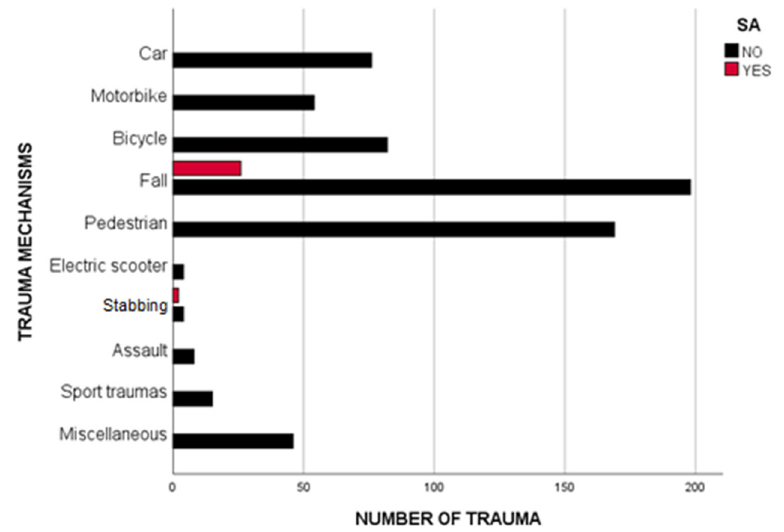
Figure 3. Trauma mechanisms in SAs in the overall period. Fall-related injuries were the predominant trauma mechanism of SAs in our series. The only other mechanism highlighted was self-stabbing. Median patients’ vital signs at first pre-hospital detection and on arrival at the ED are depicted in Table 2. Table 2. Clinical presentation: pre-hospital and ED vital signs. 2015 (N = 84)